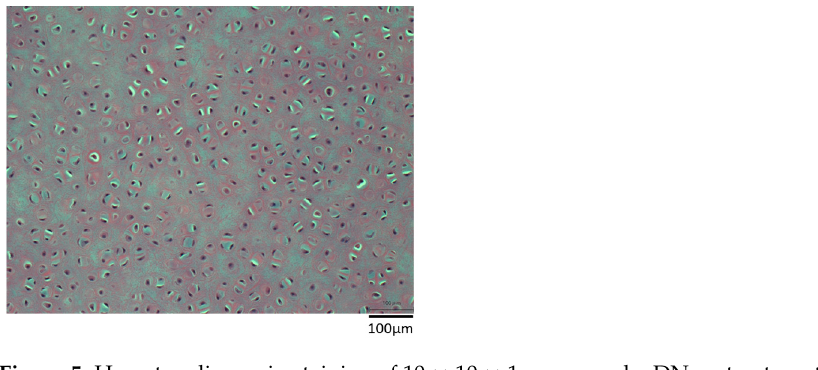
Figure 5. Hematoxylin–eosin staining of 10 × 10 × 1 mm sample. DNase treatment was applied for 7 days without degassing as a pretreatment.